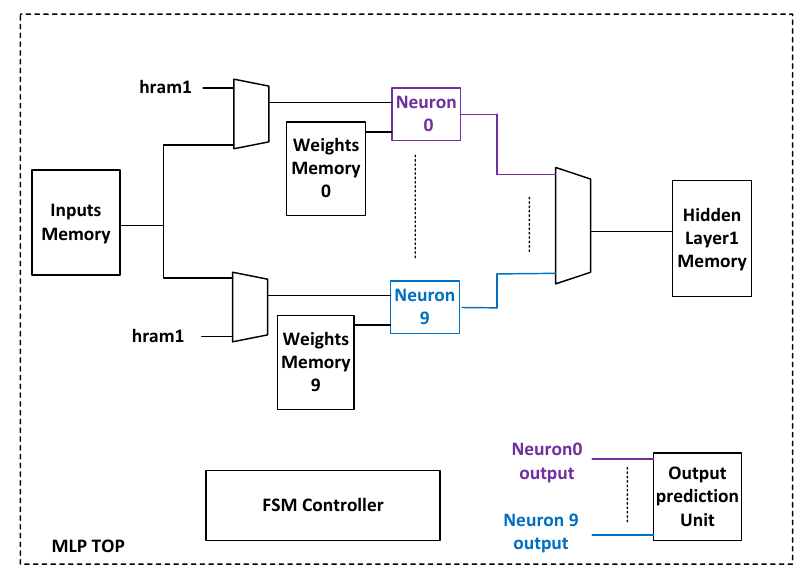
Figure 3. Block Diagram of the Network used for MNIST